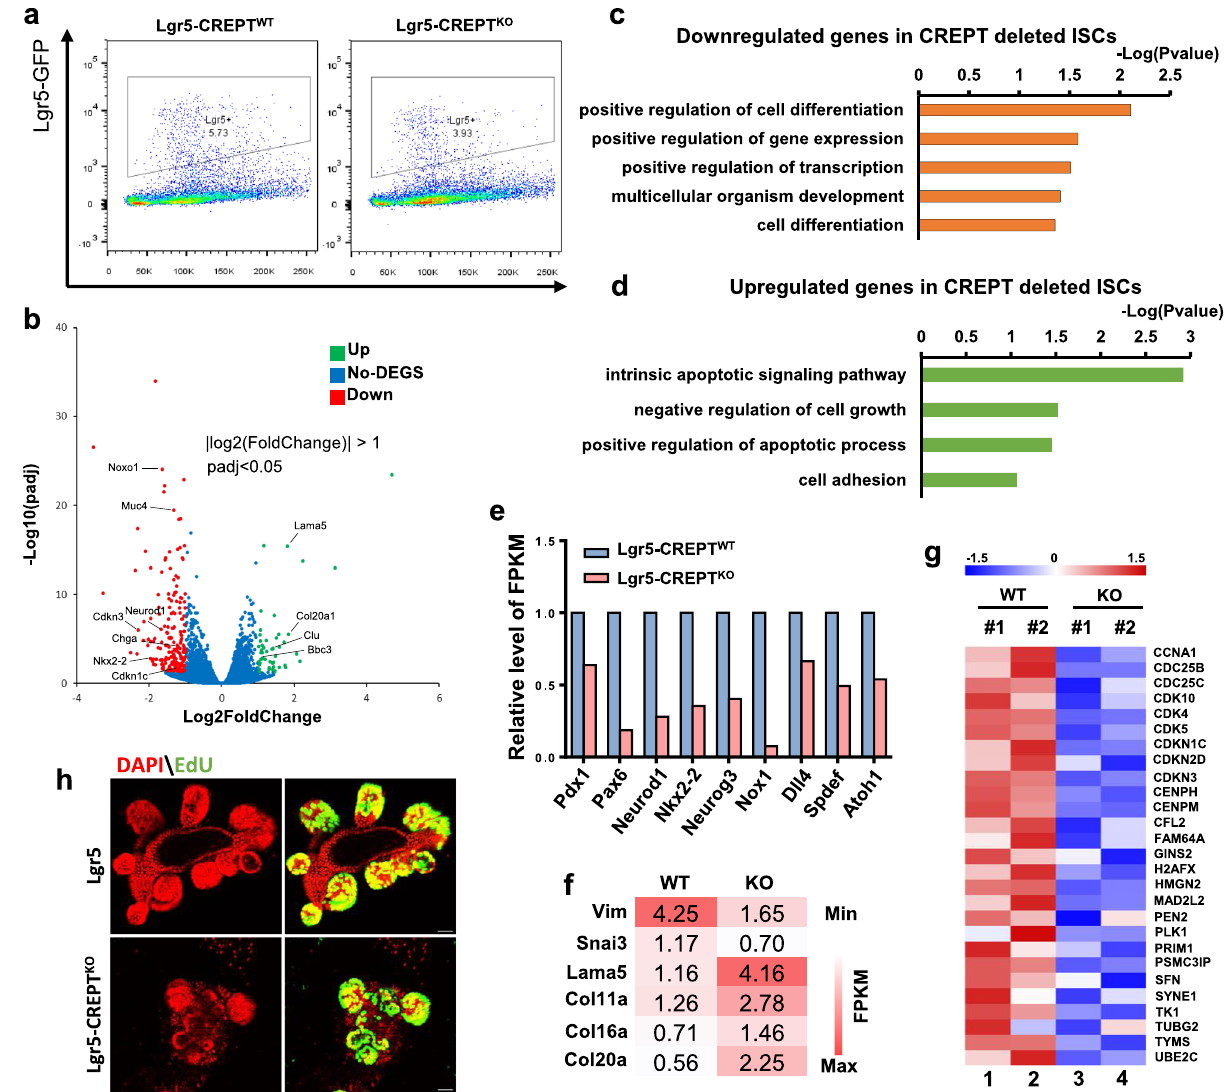
Fig. 4 CREPT maintains the proliferation and differentiation of Lgr5 + ISCs. a Gate strategy of sorting Lgr5-GFP high cells from TAM treated WT and Lgr5- CREPT KO mice. b Volcano plot showing the upregulated and downregulated genes in Lgr5-CREPT KO cells compared to Lgr5-CREPT WT ones. c , d GO analysis of downregulated genes ( c ) and upregulated genes ( d ) in CREPT deleted Lgr5 + stem cells, respectively. e Relative FPKM showing the expression of differentiation-related genes in WT and Lgr5-CREPT KO cells. Data represent mean of 2 mice per genotype derived from RNA-seq analysis. f Heatmap showing the expression of EMT-related genes of WT and Lgr5-CREPT KO cells. n = 2 mice for each genotype. g Heatmap showing the relative expression level of cell cycle promoting genes of WT and Lgr5-CREPT KO cells. n = 2 mice for each genotype. h Representative images of EdU-labeled cells in 4OHT treated intestinal organoids derived from WT and Lgr5-CREPT KO mice. Images are representative of at least three independent experiments. Scale bars: 30 μ